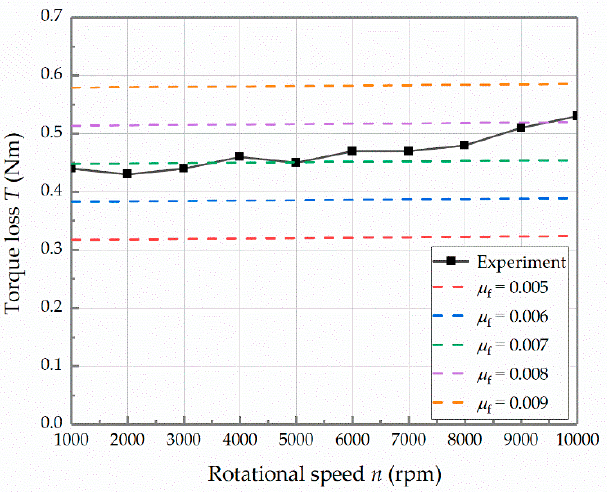
Figure 19. Analytical and experimental torque losses with respect to the rotational speed at the load pressure of 5 MPa.